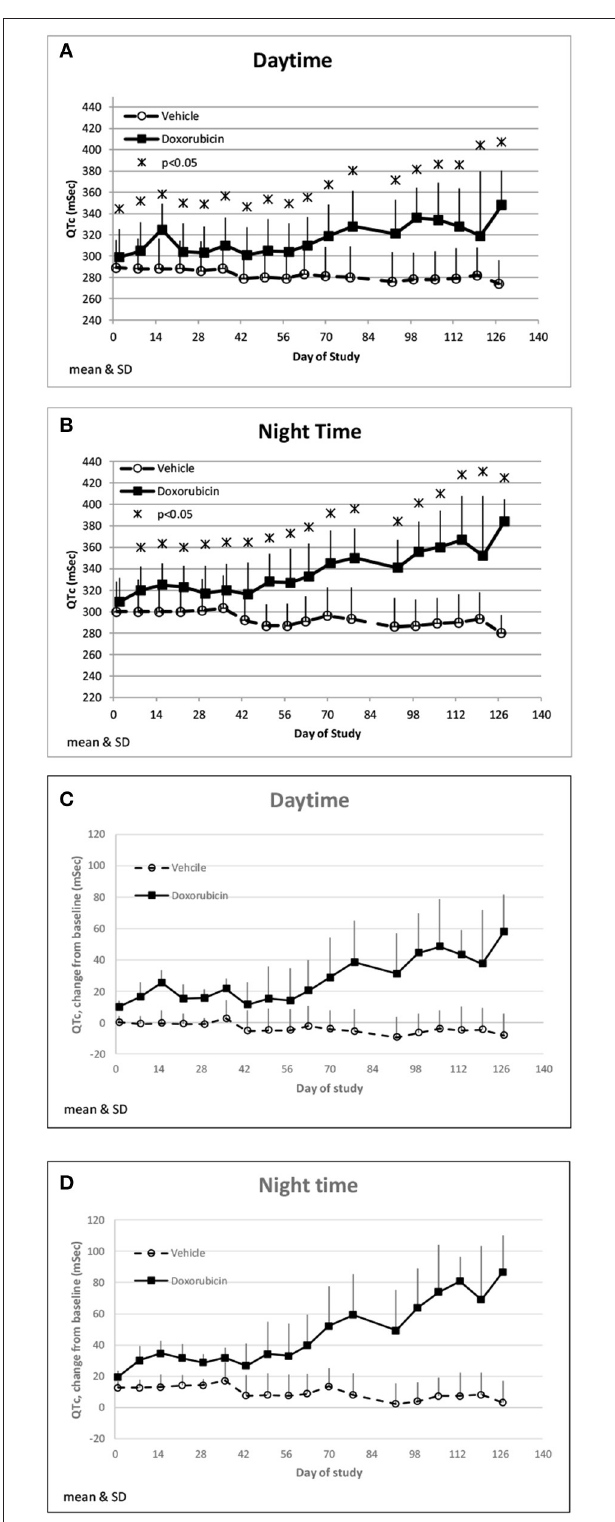
FIGURE 5 | QTc changes. Changes in QTc averaged over the day (A) and night (B) time frames over the course of the study. Changes in QTc from baseline averaged over the day (C) and night (D) time frames over the course of the